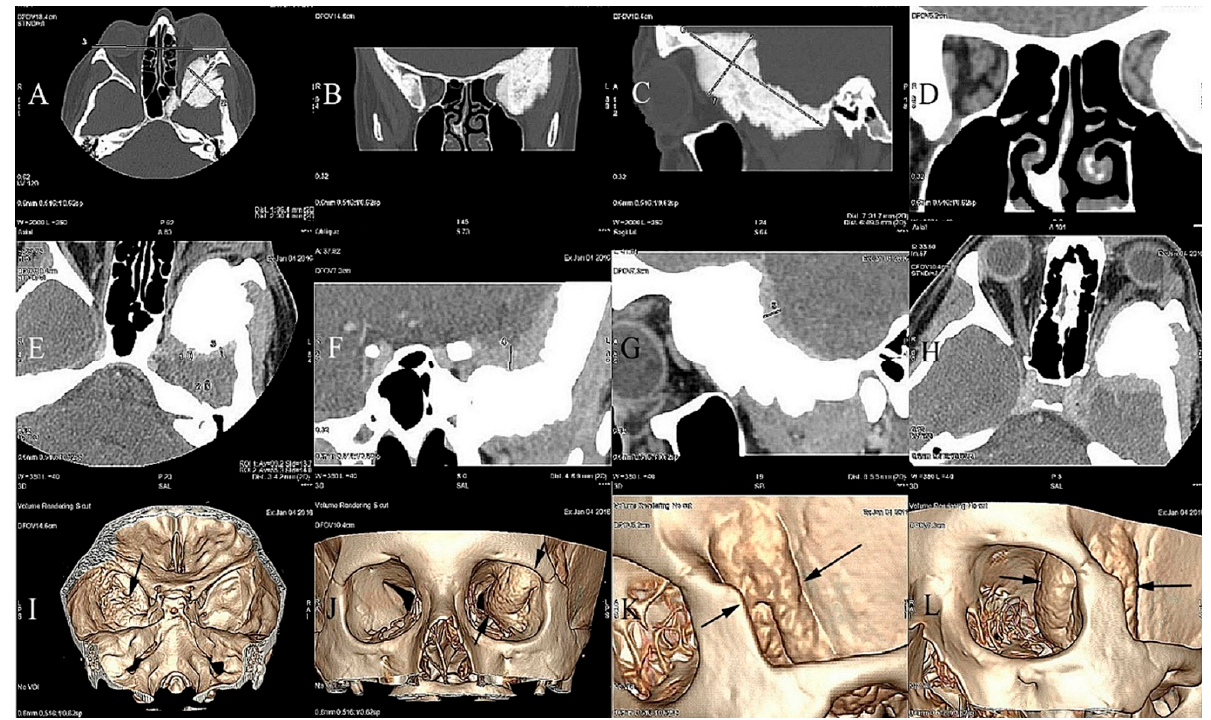
Figure 1. Craniofacial CT scan demonstrating an osteoblastic tumor measuring 36.4 × 30.4 × 89.5 mm that is invading the left greater wing of the sphenoid bone. ( A ) Exophthalmos of the left eye determined with reference to the inter-zygomatic line. Spiculated periosteal reactions ( A – C ). Orbital apex narrowing exerting pressure on the oculomotor muscles and the optic nerve ( D ). Contrast enhancement of the dura mater of the sphenoid bone up to +99 HU caused by tumor infiltration in the axial, coronal, and sagittal sections ( E – G ). Compression of the superior rectus muscle and narrowing of the optic nerve canal ( H ). Deformities of the left orbit caused by the meningioma ( I – L ) iIn 3D-CT reconstructions. The borders of the tumor are marked with black arrows.